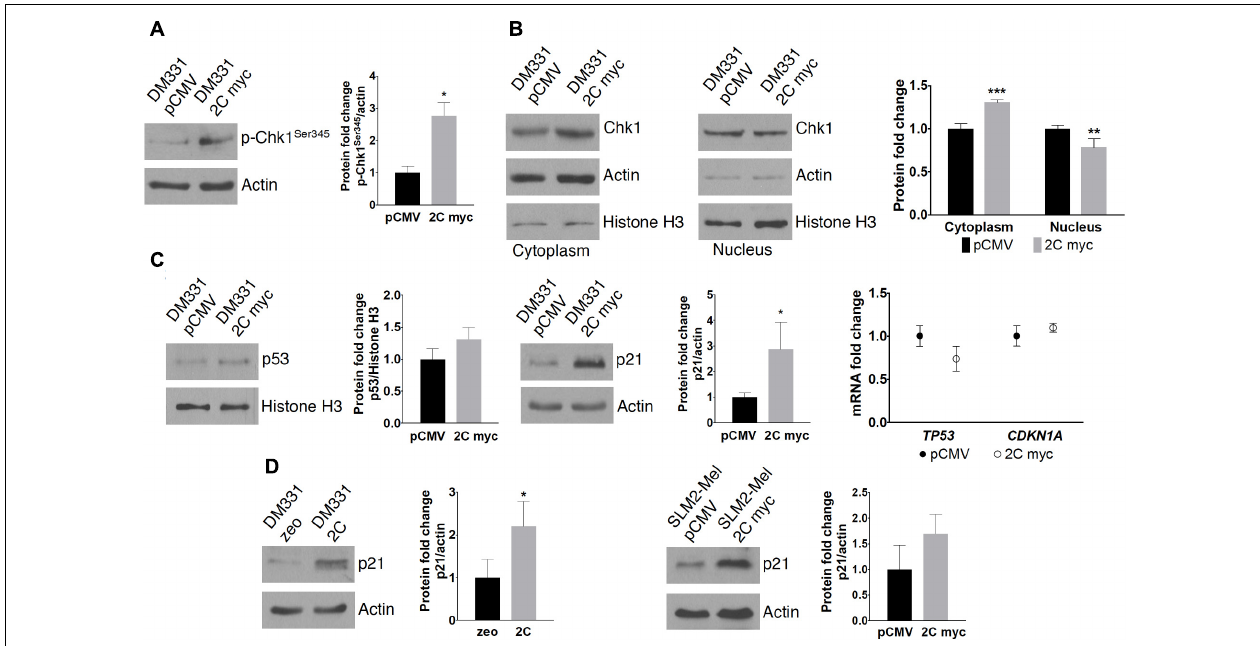
FIGURE 8 | Effect of LAMP-2C on cell cycle regulators. (A) Chk1 activation was examined by detecting cellular levels of Chk1 phosphorylation at Ser345. (B) Chk1 subcellular localization was determined by extracting cytoplasmic and nuclear proteins from DM331 pCMV and DM331 2C myc cells. Protein levels were detected by western blotting. (C) Protein and mRNA levels of cell cycle regulators in DM331 pCMV and DM331 2C myc, p53 and p21, were examined by western blotting and qPCR. (D) Lysates from DM331 zeo and DM331 2C were resolved by SDS-PAGE and probed to detect p21 levels. Protein expression was quantified by densitometry and levels were normalized to actin levels. (E) Protein levels of p21 in SLM2-Mel pCMV and SLM2-Mel 2C myc were detected by western blotting. Protein expression was quantified by densitometry and levels were normalized to actin levels. Measurements in (A–E) represent relative values calculated by setting the results obtained for cells transfected with an empty vector equal to one for comparison to cells with ectopic LAMP-2C. Data were analyzed by two-way ANOVA or by two-tailed, unpaired Student’s t -test. ∗ p < 0.05, ∗∗ p < 0.01, and ∗∗∗ p < 0.001 ( n =